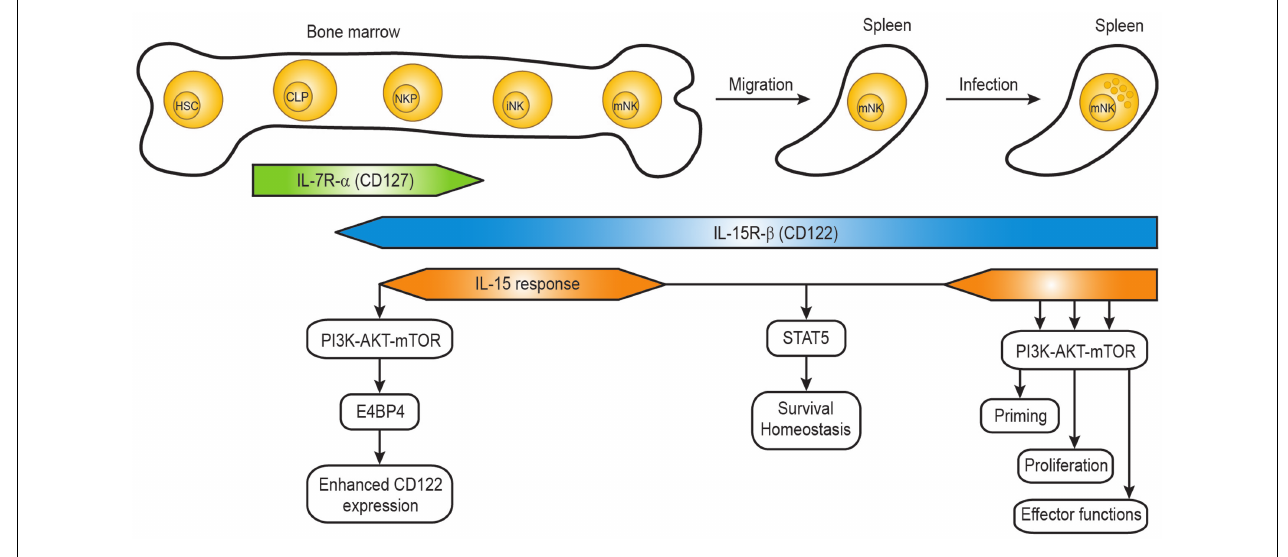
response. HSC, hematopoietic stem cell; CLP, common lymphoid progenitor; NKP, NK precursor; iNK, immature NK cell; mNK, mature NK